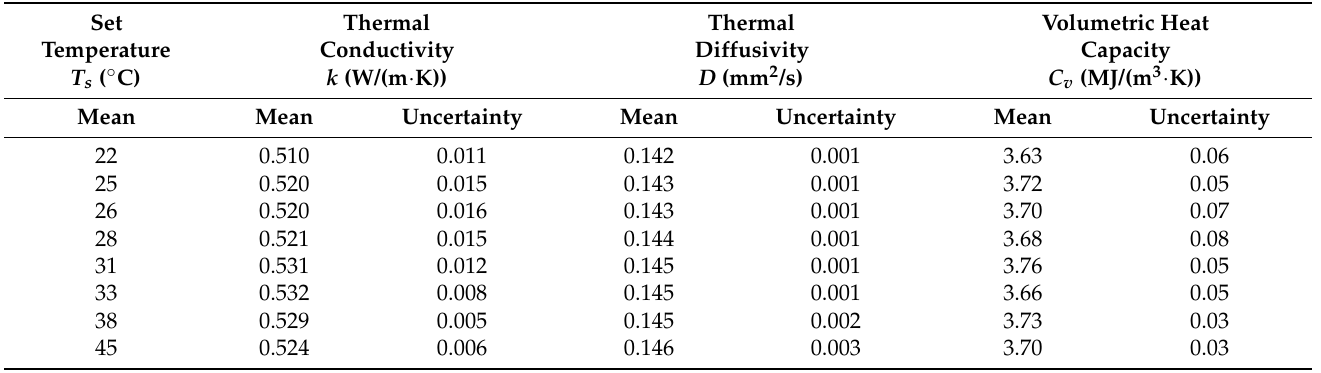
Table 5. Measured thermal properties of ex vivo porcine pancreases at different temperatures and their associated measure- ment uncertainty with 95% confidence